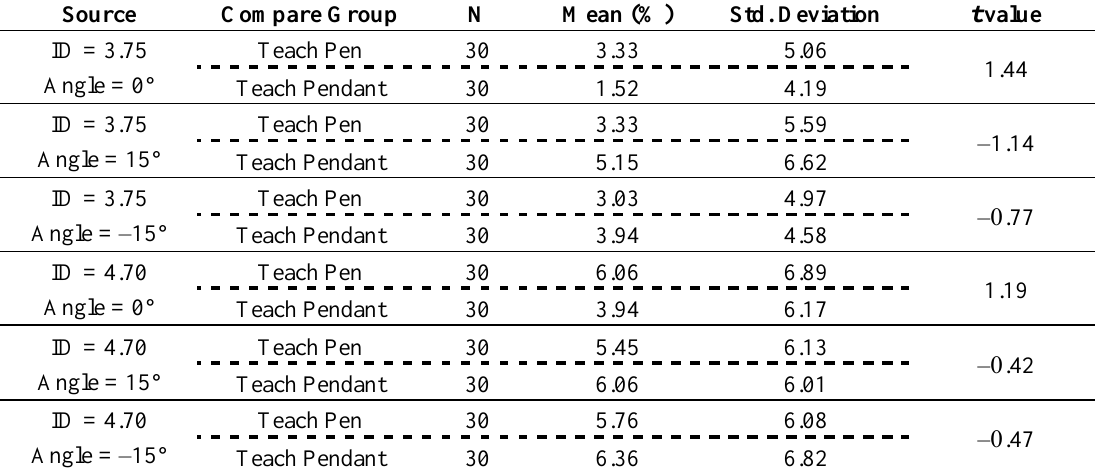
Table 7. Paired-samples t test table for the error rate for operating the two tools at the same ID and inclination